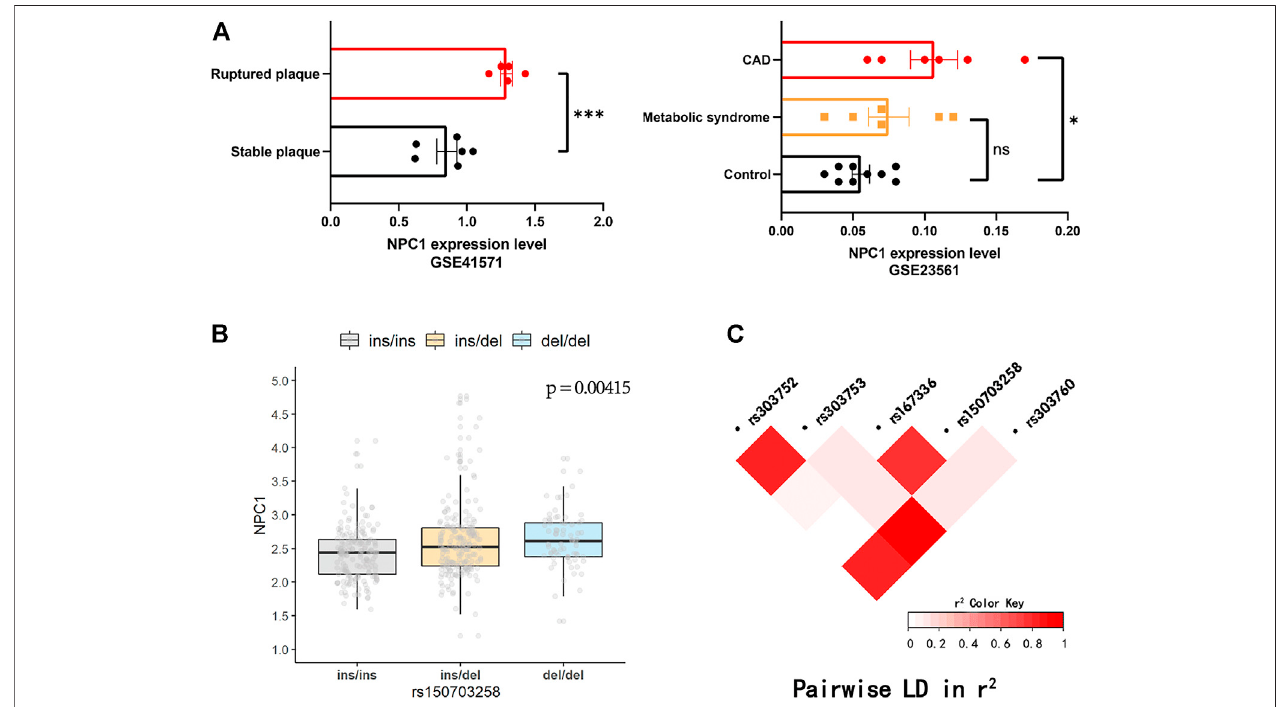
FIGURE 2 | Public database analysis and LD analysis. (A) NPC1 was up-regulated in ruptured plaque, metabolic syndrome and coronary artery disease (CAD) tissues. (* p < 0.05, *** p < 0.001). The diversity expression atlases (GSE41571 and GSE23561) were obtained from the Gene Expression Omnibus (GEO) database. (B) The validation of the regulatory effect of rs150703258 on expression of NPC1 in 445 lymphoblastoid cell lines in 1000 Genomes Project database. (C) Linkage disequilibrium (LD) analysis of rs150703258 and nearby genome-wide association (GWAS) loci.